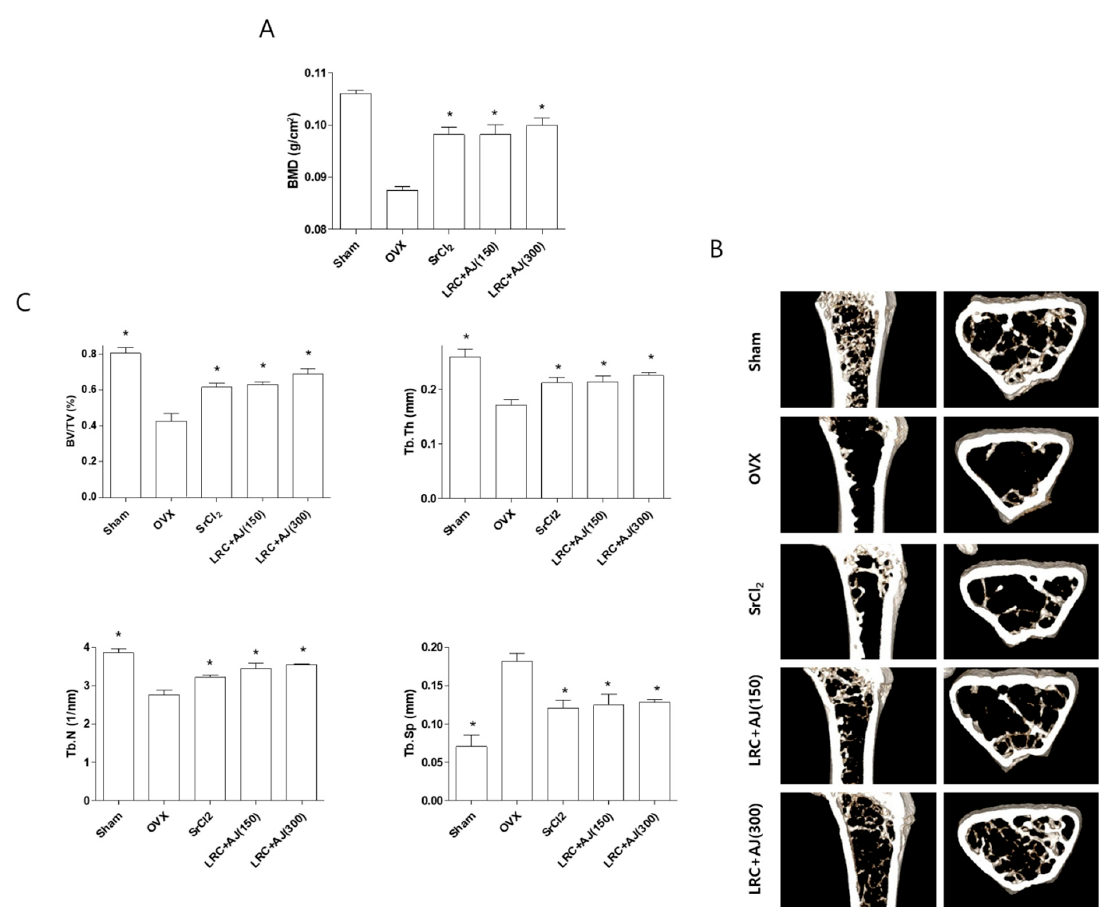
Figure 5. Anti-osteoporotic effects of LRC+AJ extract on the improvement of bone mineral density (BMD) and bone structural properties in OVX mice. The OVX mice were administered with either SrCl 2 (10 mg/kg/day) or LRC+AJ extract (150 or 300 mg/kg/day) for 12 weeks. ( A ) BMD of the right femur was measured using a PIXI-mus bone densitometer. ( B ) Transverse micro-CT images were scanned using microcomputed tomography (CT). ( C ) Trabecular bone structural properties of